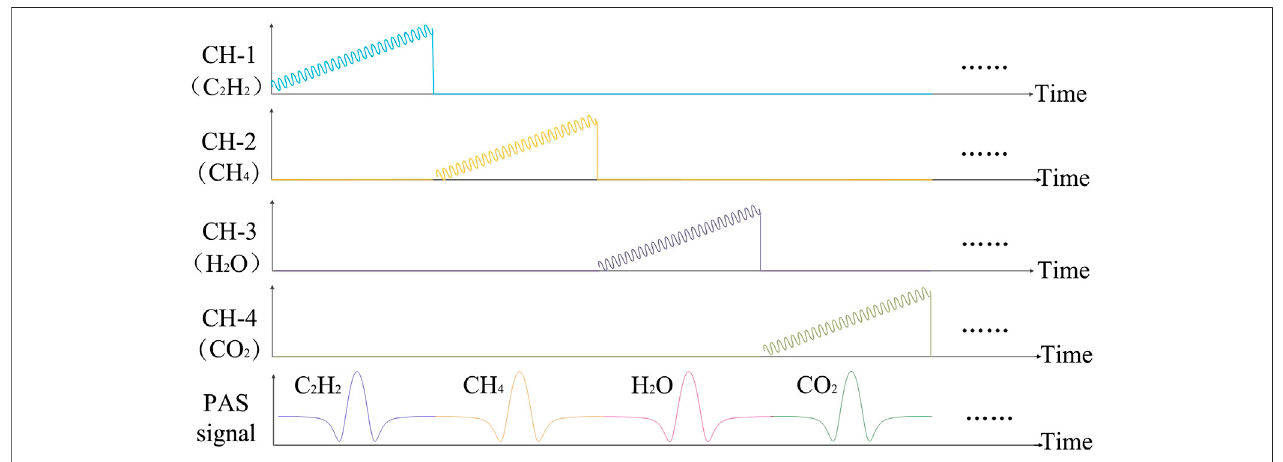
FIGURE 2 | TDM of DFB laser drive